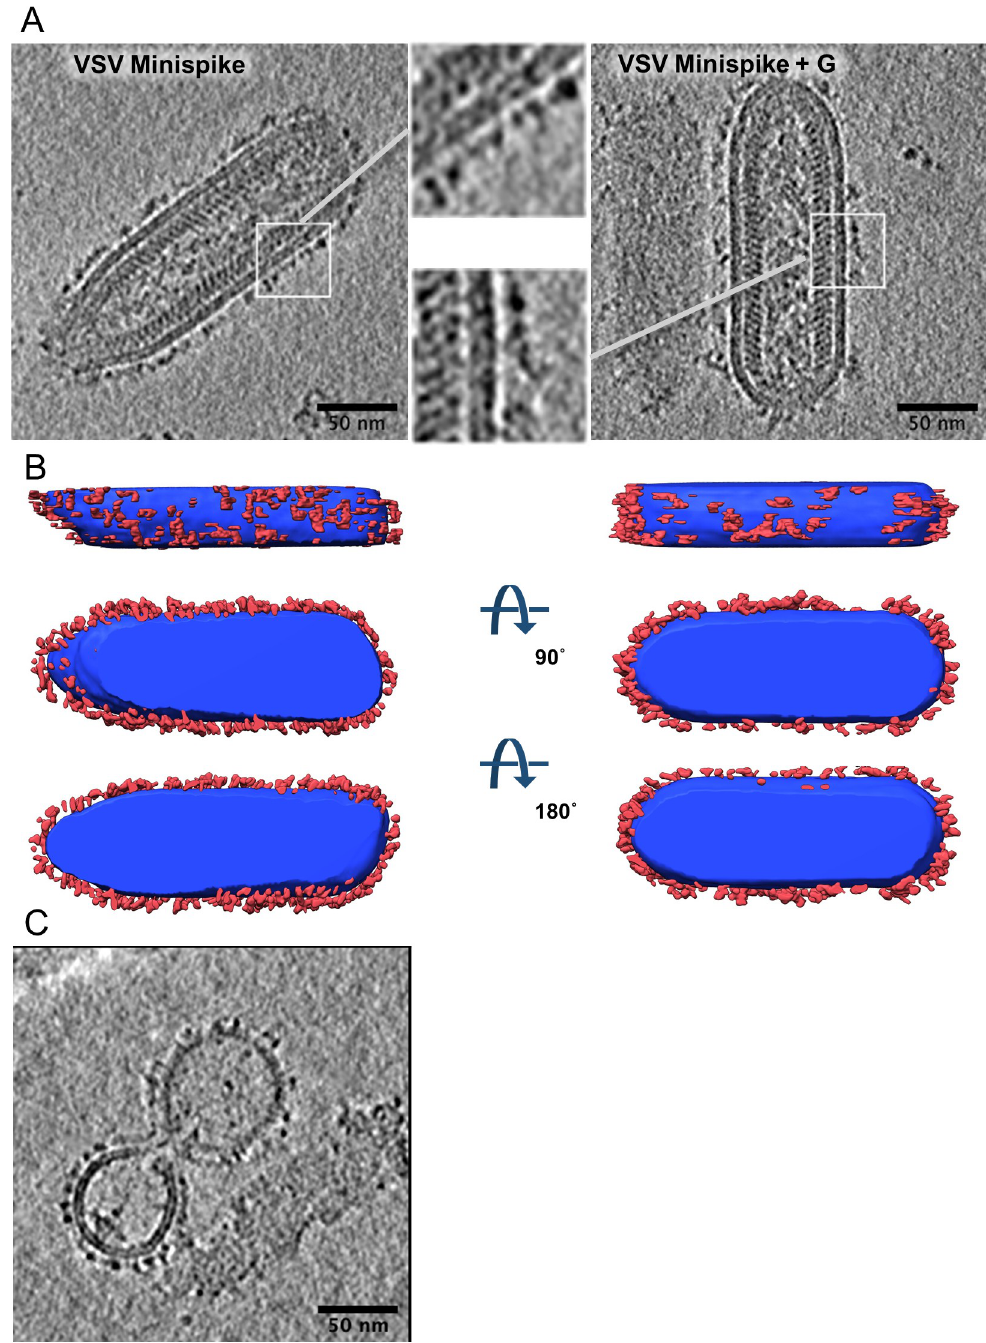
Fig 3. Characterization of minispike VLPs and mosaic viruses by cryo-EM. (A) Slices through cryo-electron tomograms of minispike-encoding VSV replicons generated in the presence of the autologous G proteins (right panel) or in the absence (left panel). Inserts show an enlarged membrane section as indicated by white squares. VSV particles are covered by a dense array of surface protrusions, which appears more heterogenous in the presence of G proteins (see S1 Fig for RABV particles and determination of length distribution). (B) Surface representation of densities of the virus particle corresponding to the membrane surrounded compartment (blue) and the surface glycoprotein layer (red). (C) VSV Δ G preparations produced in the presence of VSV G contain both virions with mosaic envelope and G-coated non-viral vesicles (aka Gesicles).